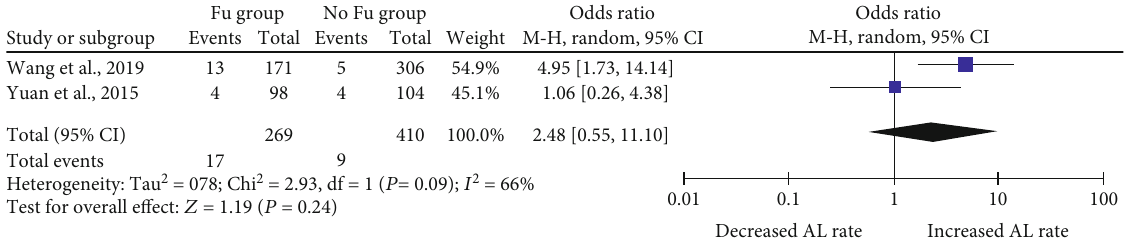
post colorectal surgery and anastomotic leak rate. wh